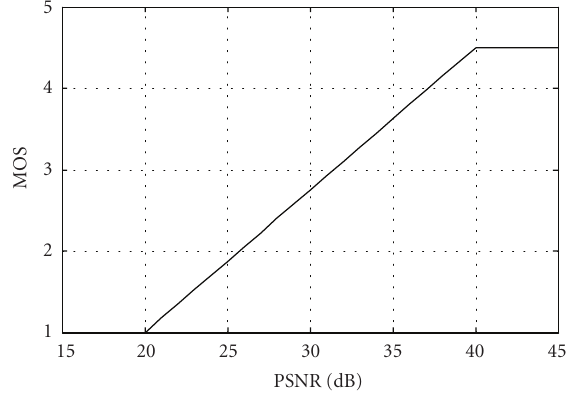
Figure 5: MOS versus